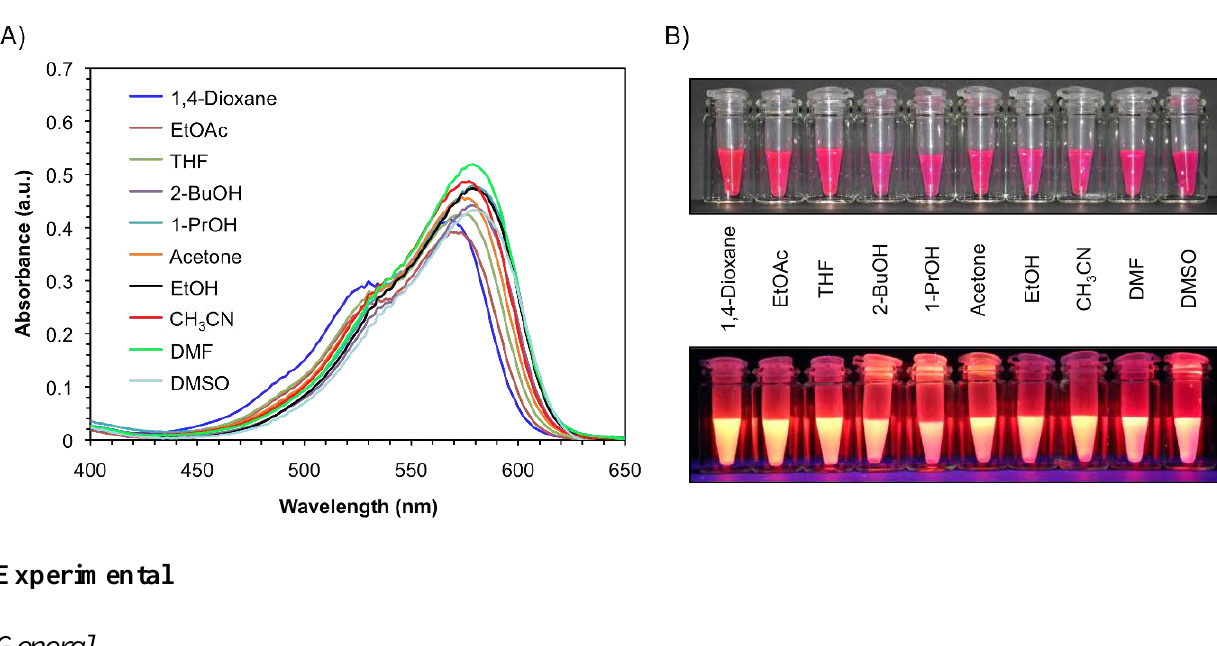
Figure 1. ( A ) UV-vis spectra of modified dye 3 in different organic solvents ( c = 3.8 × 10 −5 mol·L −1 ) showing a positive solvatochromism; ( B ) Appearance of solutions of dye 3 in different organic solvents ( c = 2.8 × 10 −4 mol·L −1 ) under ( top ) visible and ( bottom )